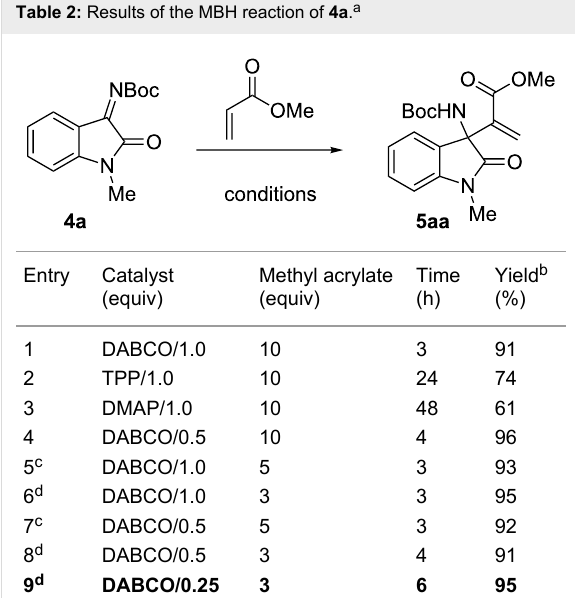
Table 2: Results of the MBH reaction of 4a .